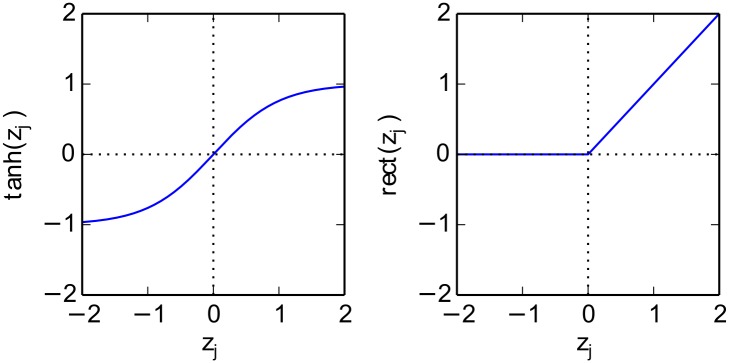
Example of non-linear activation functions g used in multilayer neural networks.